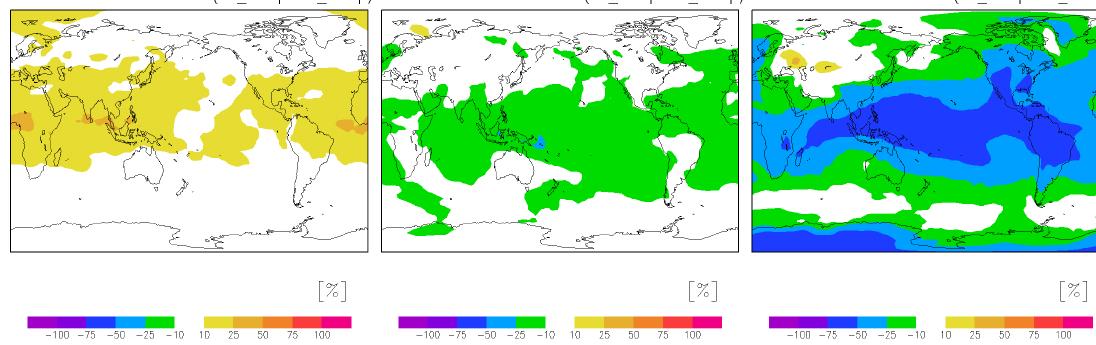
Fig. 4. The geographic distribution of annual mean soluble/internally mixed (Sol.) Aitken, accumulation (Accum.) and coarse mode number burdens for the simulation CF loimp (top panels) and the percent difference of simulations PF std and CF hiimp with respect to CF loimp (remaining panels). Simulations are described in Table